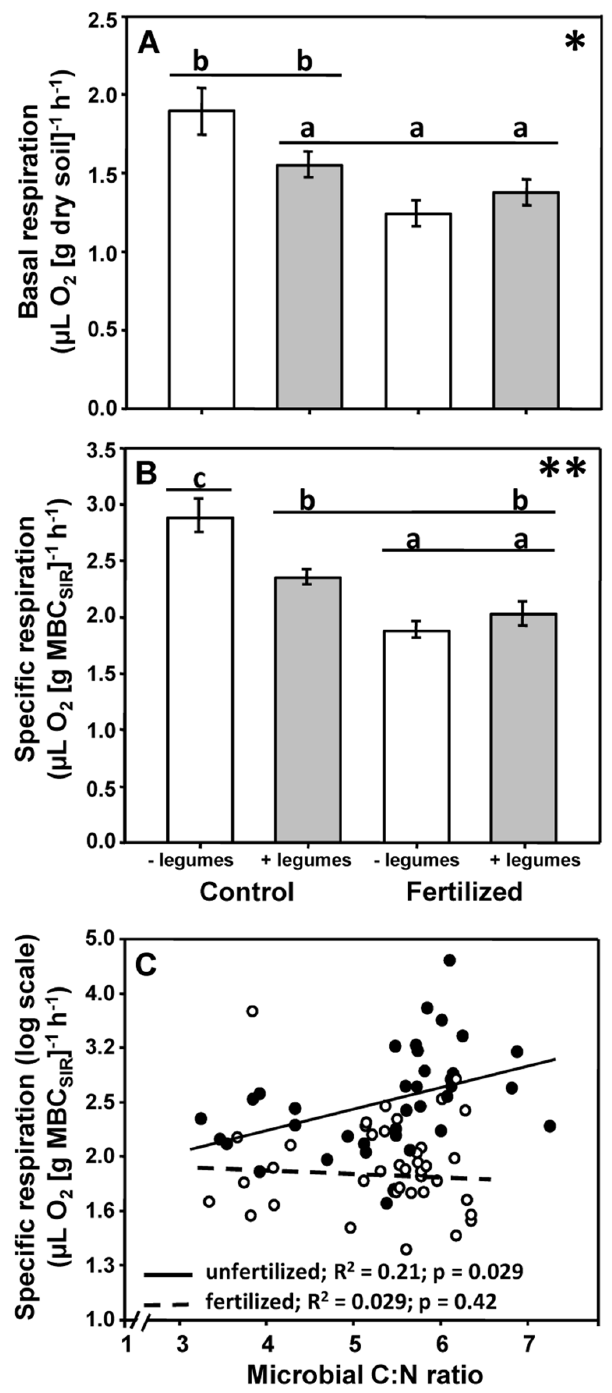
Fig 2. Interactive effects of the presence of legumes and fertilization on microbial basal respiration and specific respiration, and correlation between microbial C-to-N ratio and microbial specific respiration in fertilized and unfertilized plots. (A) Interactive effects of the presence of legumes and fertilization on soil microbial basal respiration and (B) specific respiration. Means with standard error bars. Different letters indicate significant differences ( * p (cid:1) 0.05; ** p (cid:1) 0.01). (C) Regressions between soil microbial C-to-N (C:N) ratio and specific respiration in unfertilized plots (black line, black dots) and fertilized plots (dashed line, white dots) with coefficients of determination and p-values of